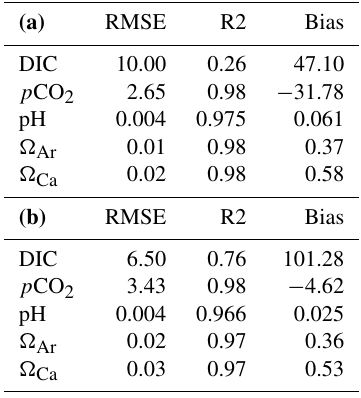
Table 4. Model validation metrics for the (a) high-latitude and (b) low-latitude ocean carbonate variables in the comparison of Hector to CMIP5 from 1850 to 2005.